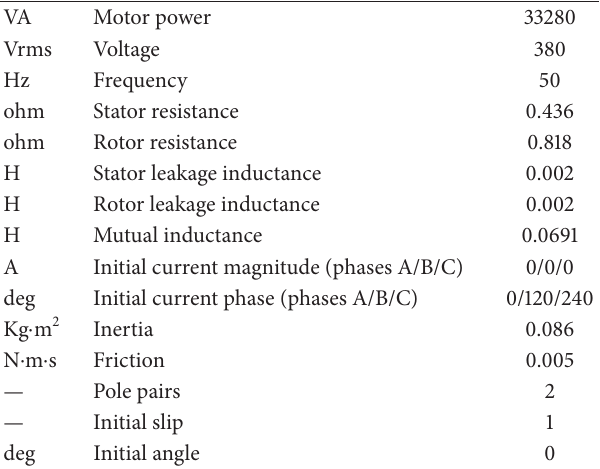
Table 1: Physical and simulation parameters for coiling asyn- chronous motor.